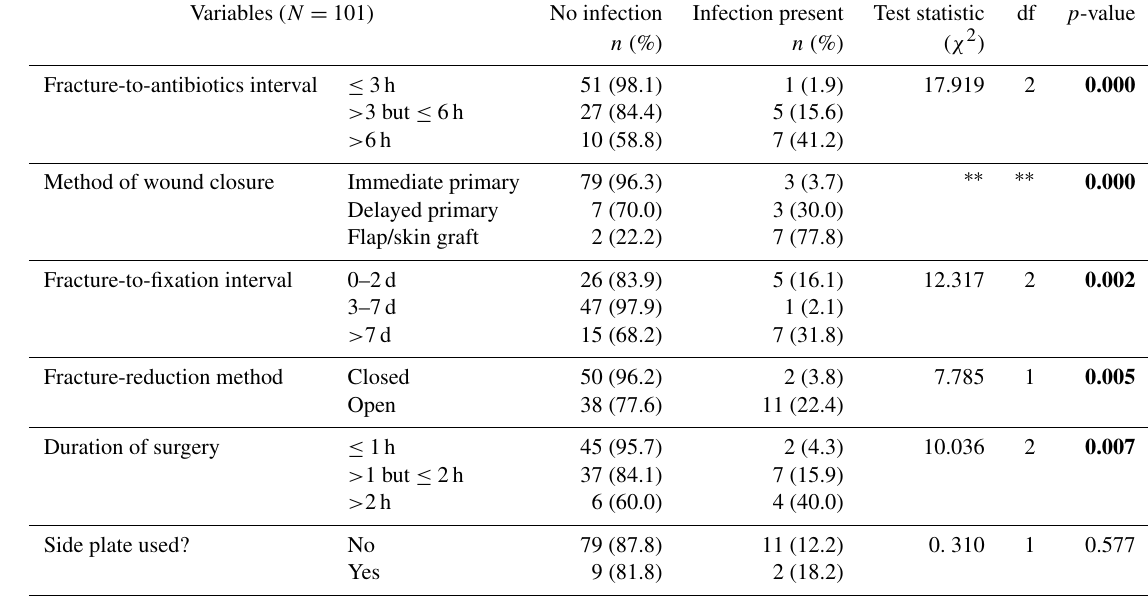
Table 2. Cross-tabulation of treatment-related factors and infection ( N = 101).